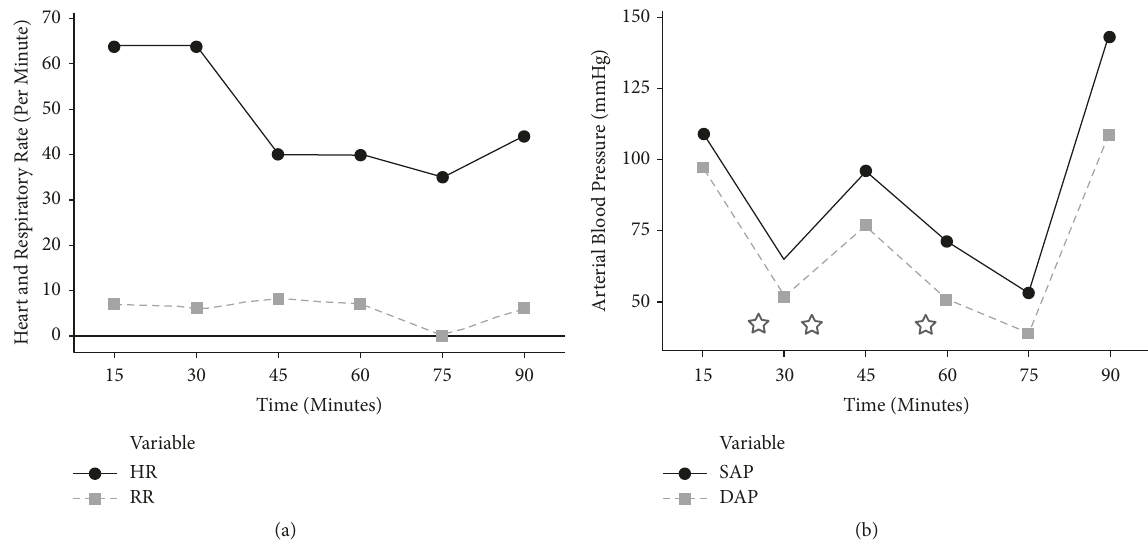
Figure 1: (a) Course of the respiratory rate (RR) (breaths per minute) and heart rate (HR) (beats per minute); (b) diastolic arterial blood pressure(DAP)(mmHg),andsystolicarterialbloodpressure(SAP)(mmHg)duringtheanaestheticprocedureinasubadultwhiterhinoceros. Time is the elapsed time after recumbency. Medetomidine administration (stars) caused an increase in blood pressure resulting from peripheral vasoconstriction. IPPV was initiated at minute